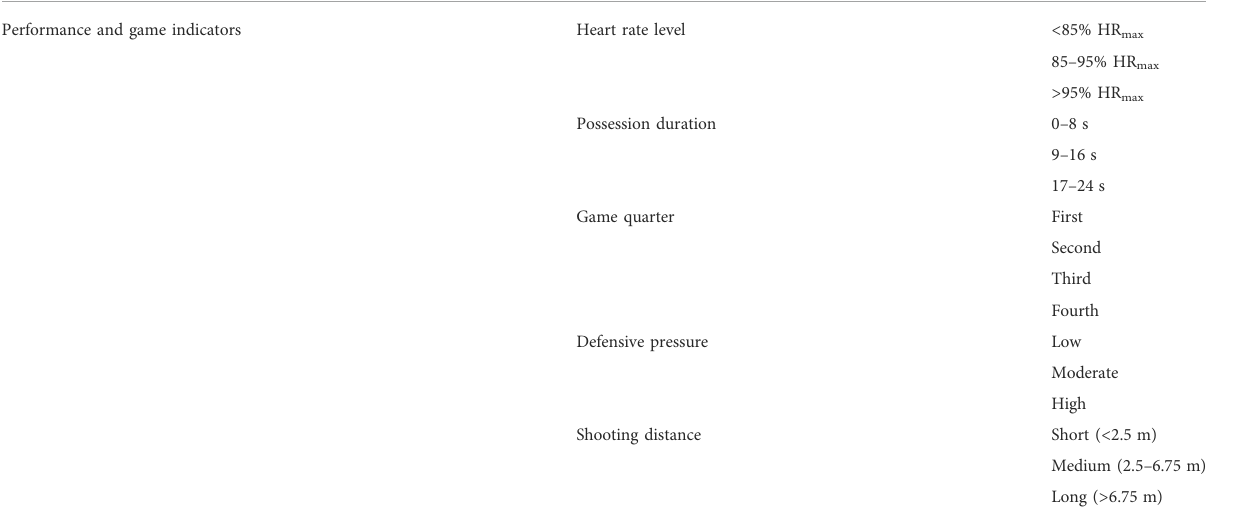
TABLE 1 Performance and game indicators observed in relation to shooting ef fi ciency (i.e., made, missed).